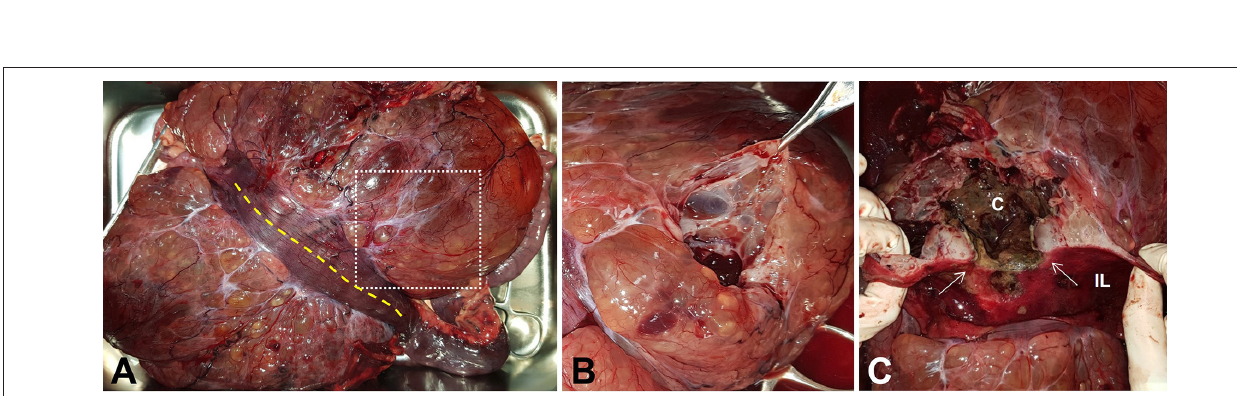
FIGURE 3 | Gross photographs of the resected mass and jejunal segment. (A) Antimesenteric side view shows the mass with multicystic appearance. (B) The cut surface of the mass indicated as white dotted square in (A) reveals polycystic changes. (C) Oval-shaped fistula (white arrows) with surrounding mucosal ulceration is exposed through jejunal incision indicated as yellow dotted line in (A) . The cut surface of the fistulated intestinal wall reveals the exophytic growth pattern of the mass and the connection between intestinal lumen and necrotic cavity located at the core of the mass. C, cavity; IL, intestinal lumen. gastrointestinal stromal tumor ( Figure 4C ). Neoplastic cells anisocytosis and anisokaryosis ( Figure 4B ). The mitotic demonstrated strong cytoplasmic labeling for smooth muscle index was 3 per 10 high-power fields. Immunohistochemistry actin ( Figure 4D ) and desmin ( Figure 4E ). Based on labeling for CD117 was diffusely negative, which ruled out